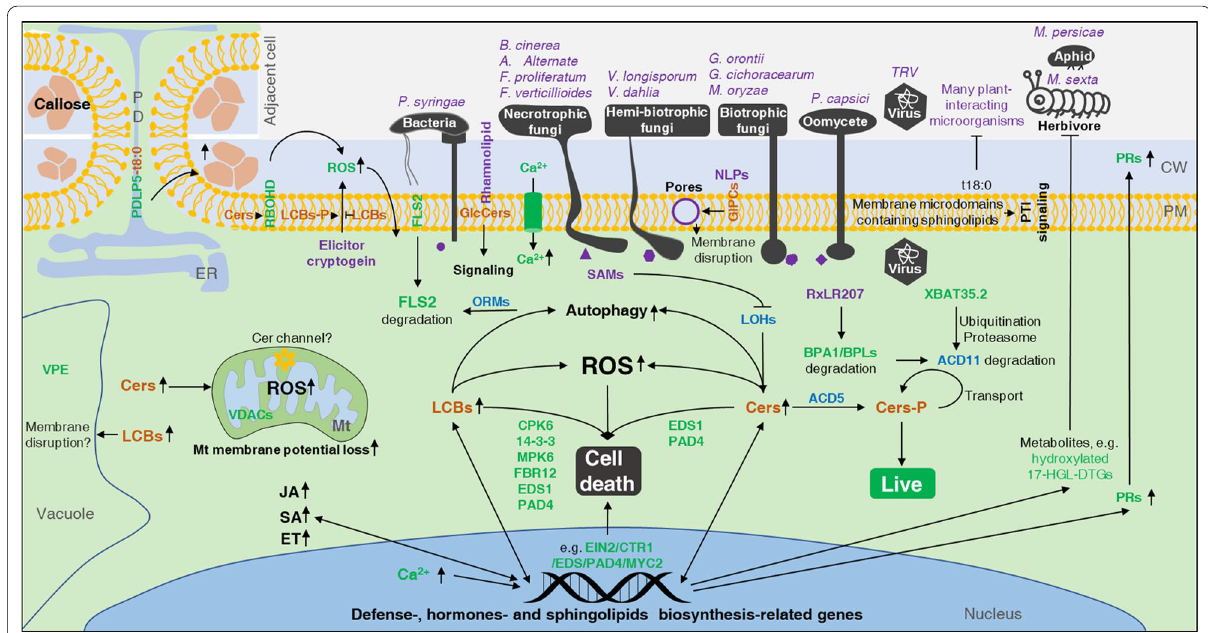
Fig. 2 An overview of sphingolipid functions in plant immunity. ABA: abscisic acid; ACD5, ceramide kinase; ACD11, ceramide‑P transporter; Cers, ceramides; Cer‑P: ceramide‑phosphate; CPK3: CALCIUM‑DEPENDENT KINASE; CTR1, CONSTITUTIVE TRIPLE RESPONSE 1; CW: cell wall; EDS1: ENHANCED DISEASE SUSCEPTIBILITY; EIN2: ETHYLENE INSENSITIVE 2; ER: endoplasmic reticulum; ET: ethylene; FB1: Fumonisin B1, an inhibitor of ceramide synthase; FBR12, FB1‑RESISTANT 12; flg22: flagellin‑derived peptide flagellin 22; FLS2: FLAGELLIN SENSING 2; GIPCs: glycosyl inositol phosphoceramides; GlcCers: glucosylceramides; JA: jasmonic acid; LCBs, long‑chain bases; LCBs‑P, long‑chain base‑phosphate; LOH: LAG ONE HOMOLOGUES, ceramide synthases; MPK6: mitogen‑activated protein kinase 6; Mt, mitochondrion; NLPs: necrosis and ethylene‑inducing peptide 1‑like proteins; ORMs: orosomucoid‑like proteins; PAD4: PHYTOALEXIN DEFICIENT 4; PCD: programmed cell death; PD: plasmodesmata; PDLP5: PD‑LOCATED PROTEIN 5; PM: plasma membrane; PRs, PATHOGENESIS‑RELATED proteins; RBOHD: RESPIRATORY BURST OXIDASEHOMOLOGUE D; ROS, reactive oxygen species; SA: salicylic acid; SAMs: sphinganine‑analog mycotoxins; TRV, tobacco rattle virus; VDACs: voltage‑dependent anion channels; VPE: vacuolar processing enzyme; SL: sphingolipid; t18:0: phytosphingosine or